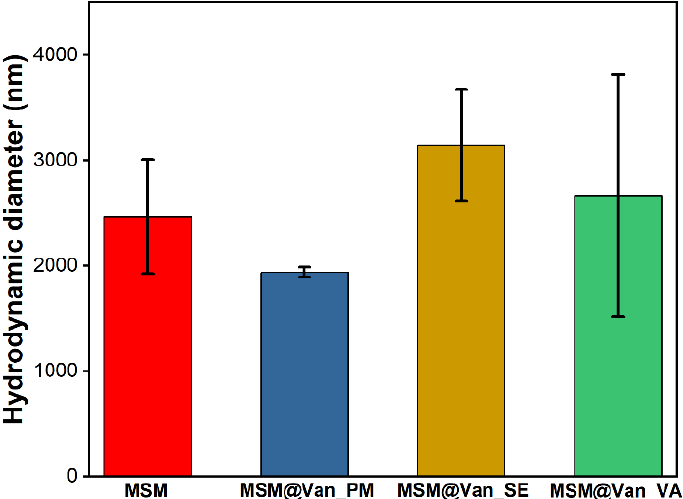
Figure 6. Average hydrodynamic diameter for pristine and vancomycin-loaded MSM. Regardless of the method used for loading, vancomycin had an extended-release compared to the pure drug. For comparison, the expected maximum amount of vancomycin (15 mg) was also placed in a filter bag, and we waited for its complete dissolution in SBF (until reaching plateau). As Figure 7 depicts, pure vancomycin showed a fast release rate,